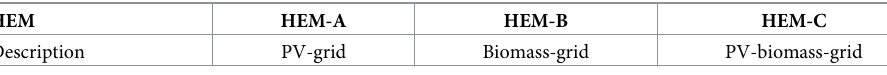
Table 4. Various possible hybrid energy